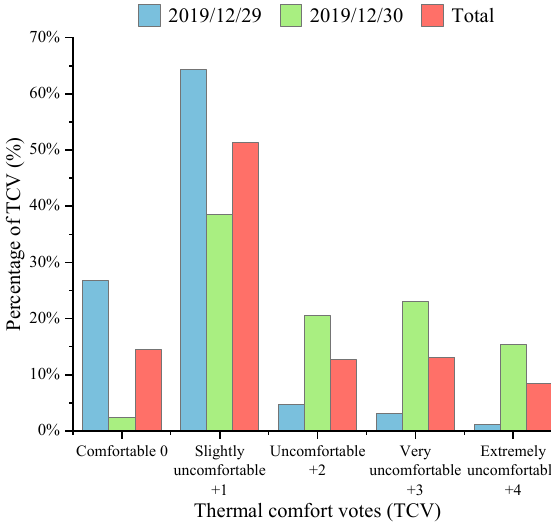
Figure 8. Frequency of the TCVs.